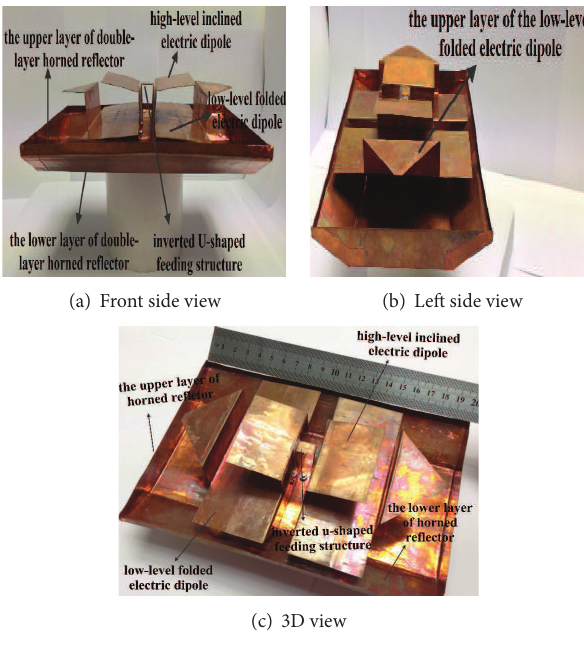
Figure 11: Photos of the proposed antenna.